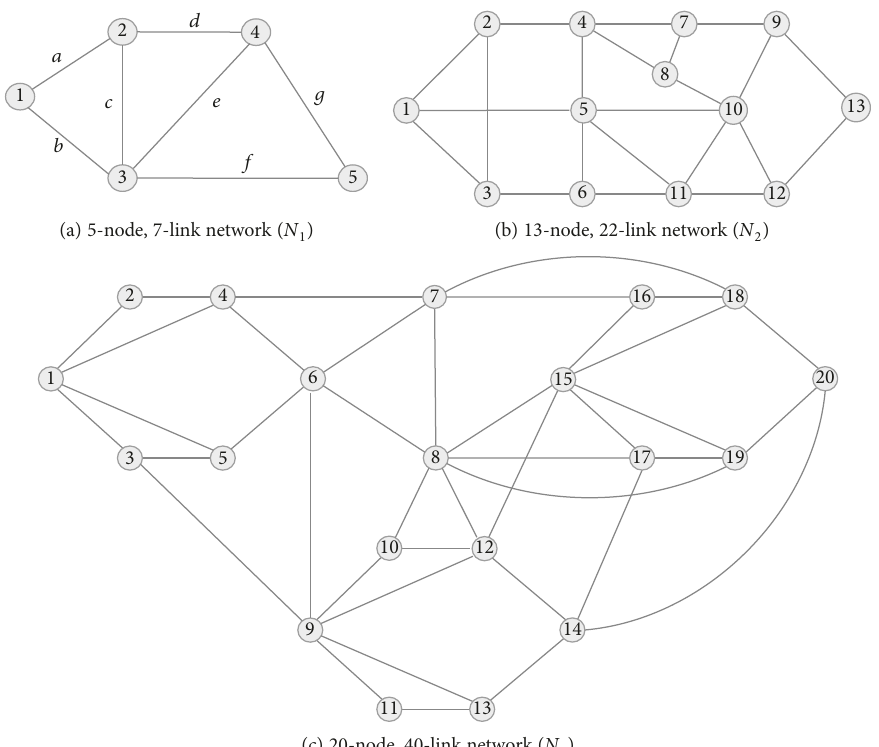
1 ); (b) 13-node, 22-link network ( N 2 ); (c) 20-node, 40-link